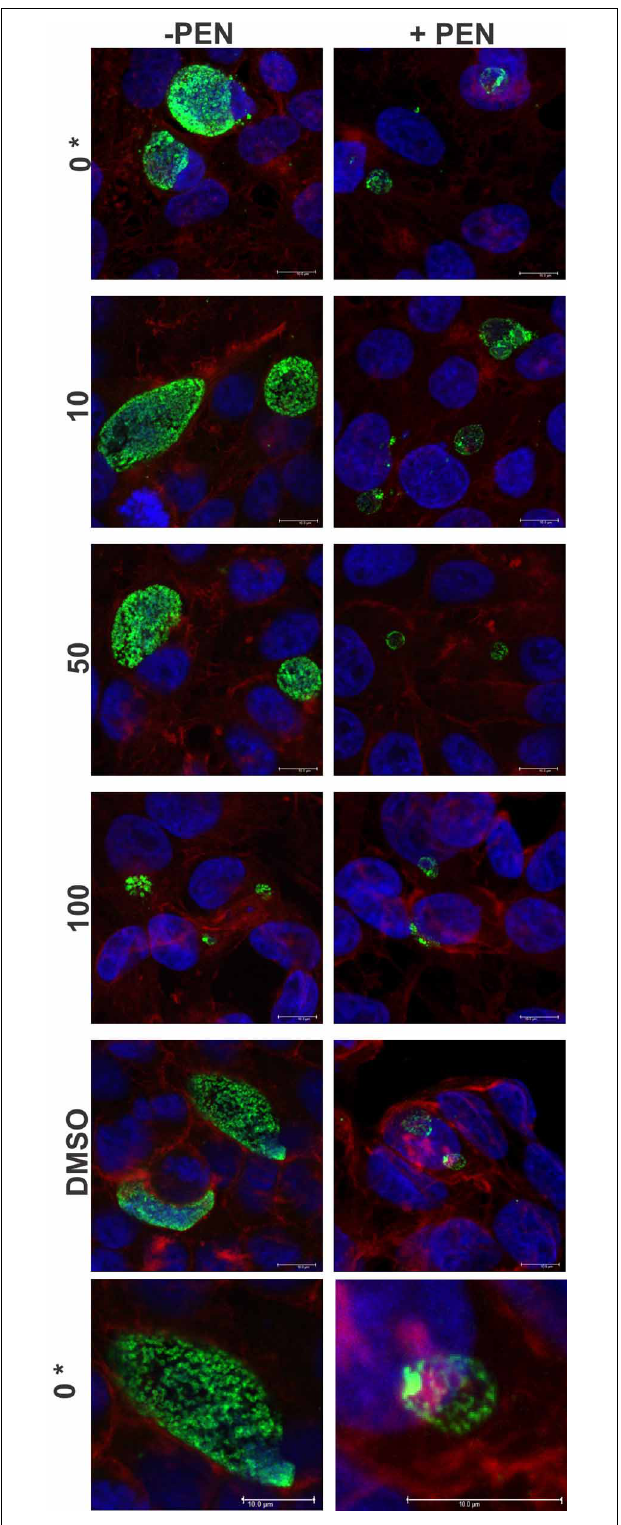
FIGURE 2 | Confocal microscopy images of JO146 treated cultures during penicillin persistence at 44h PI ( + PEN: penicillin added, − PEN: no penicillin). The figure shows representative images from confocal laser